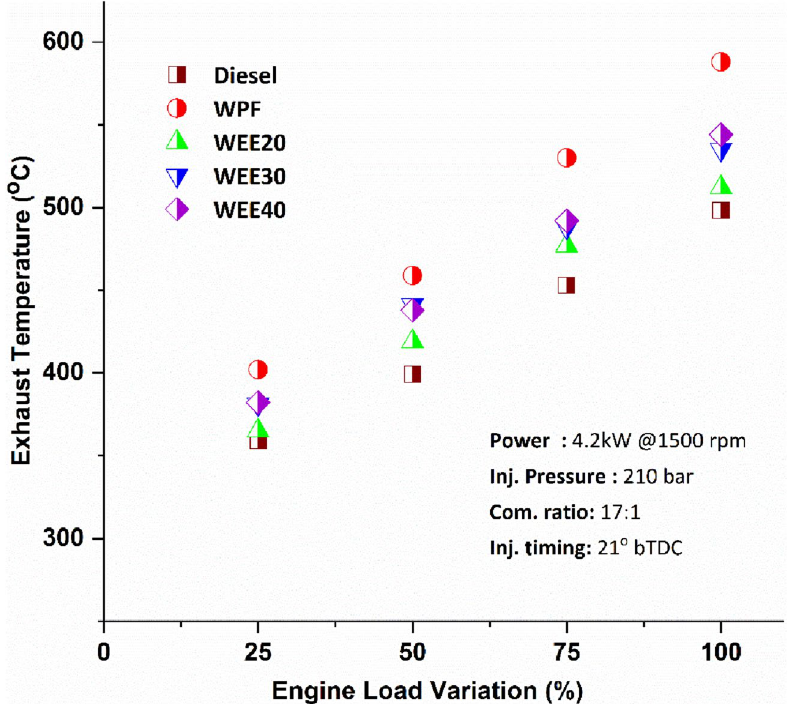
Figure 4. Variation of Exhaust gas temperature on engine